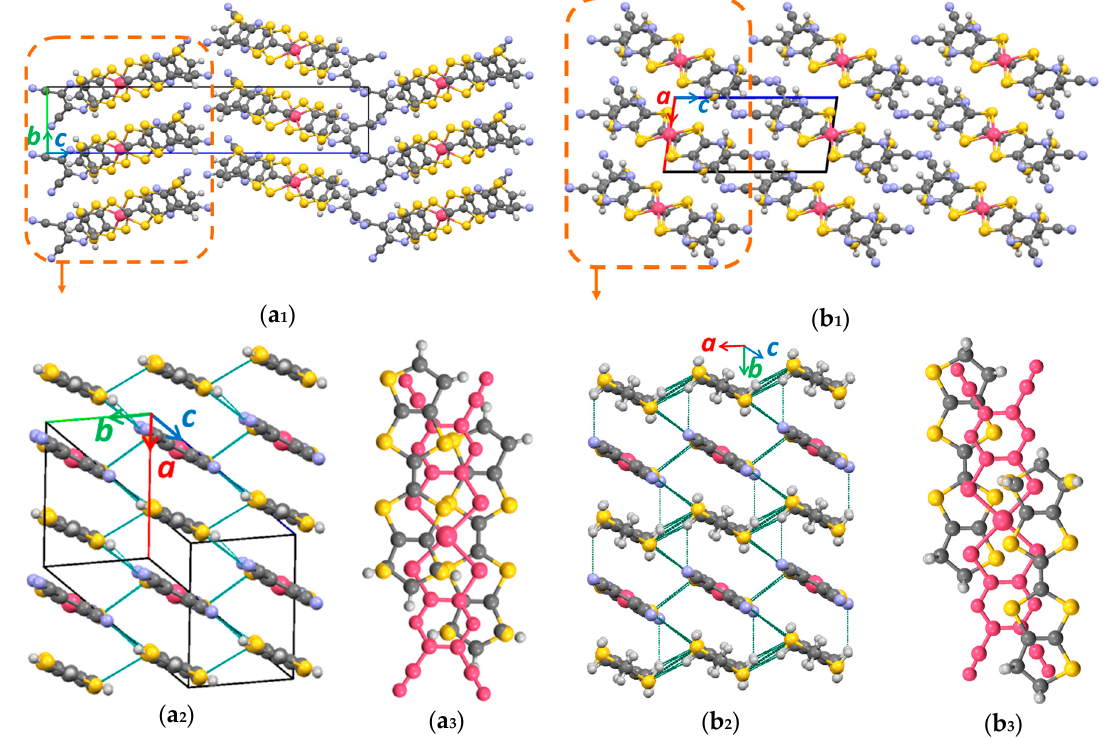
Figure 2. Crystal structure of compound 1 ( a ) and compound 2T ( b ): ( a 1 , b 1 ) view along the stacking axis; ( a 2 , b 2 ) partial view along the long axis of molecules of neighbouring stacks in the same layer; ( a 3 , b 3 ) overlap mode of the mixed stacks. Thin lines represent relevant short contacts.